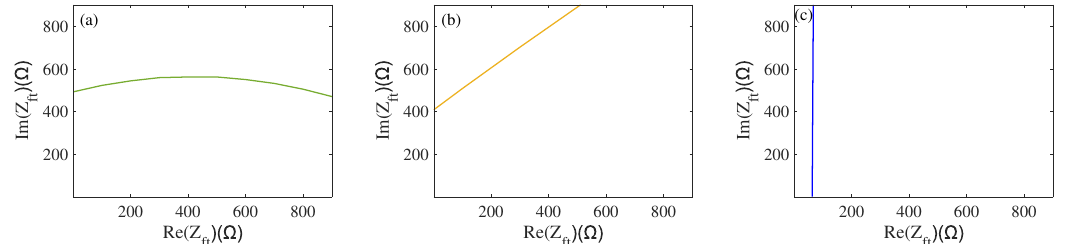
Figure 12. ( a ) Two-dimensional intersection of f s ; ( b ) Two-dimensional intersection of f 1 ; ( c ) Two- dimensional intersection of R .